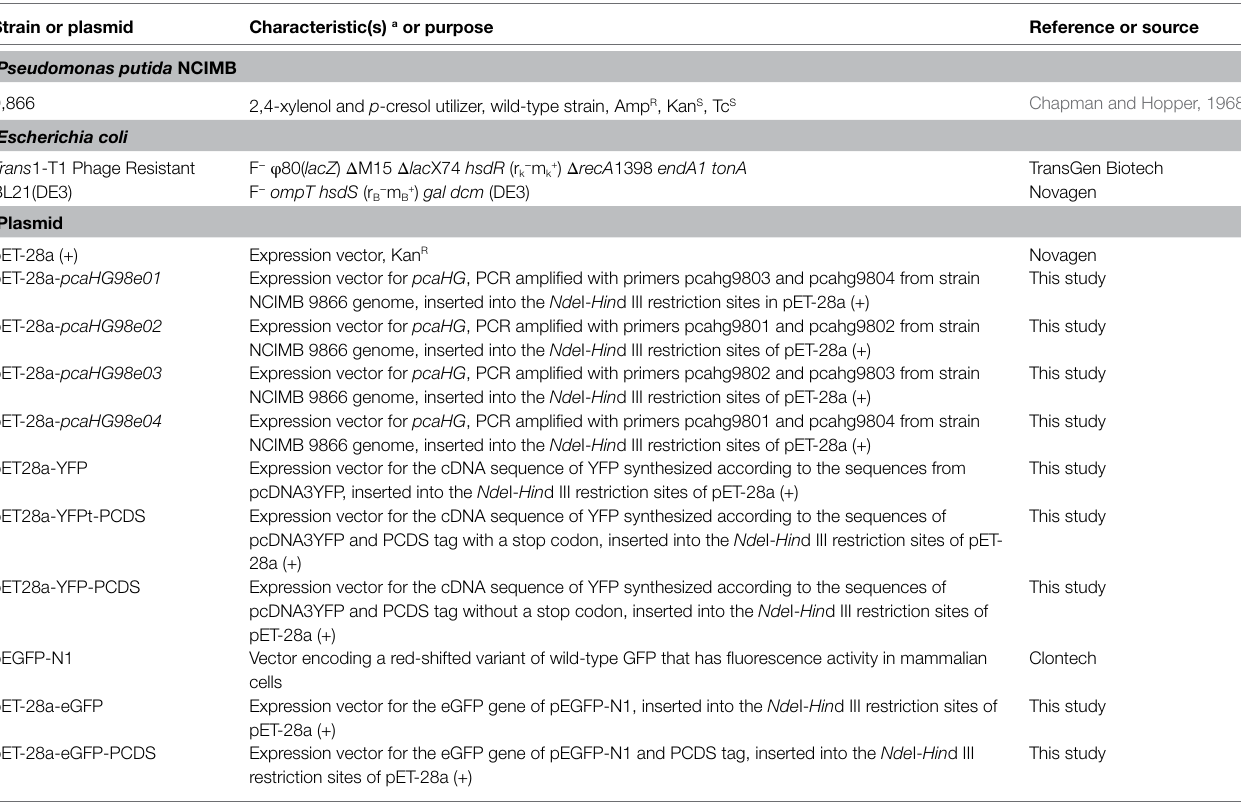
TABLE 1 | Strains or plasmids used in this